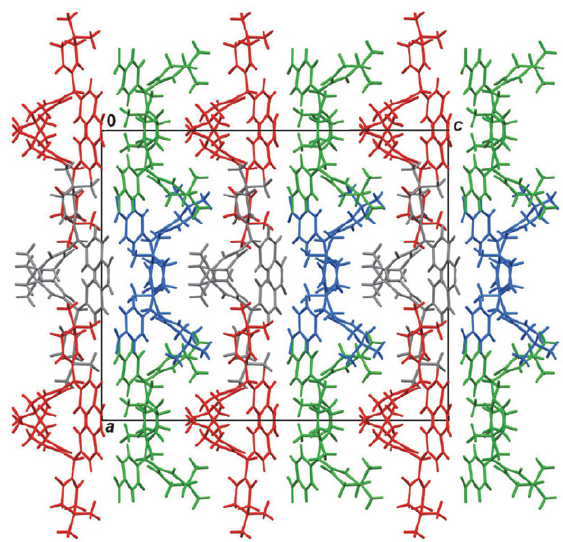
Figure 5. Crystal packing of 1 viewed in the direction [010]. Sym- metry-independent molecules are shown in different colors: a are green, b are blue, c are red and d are